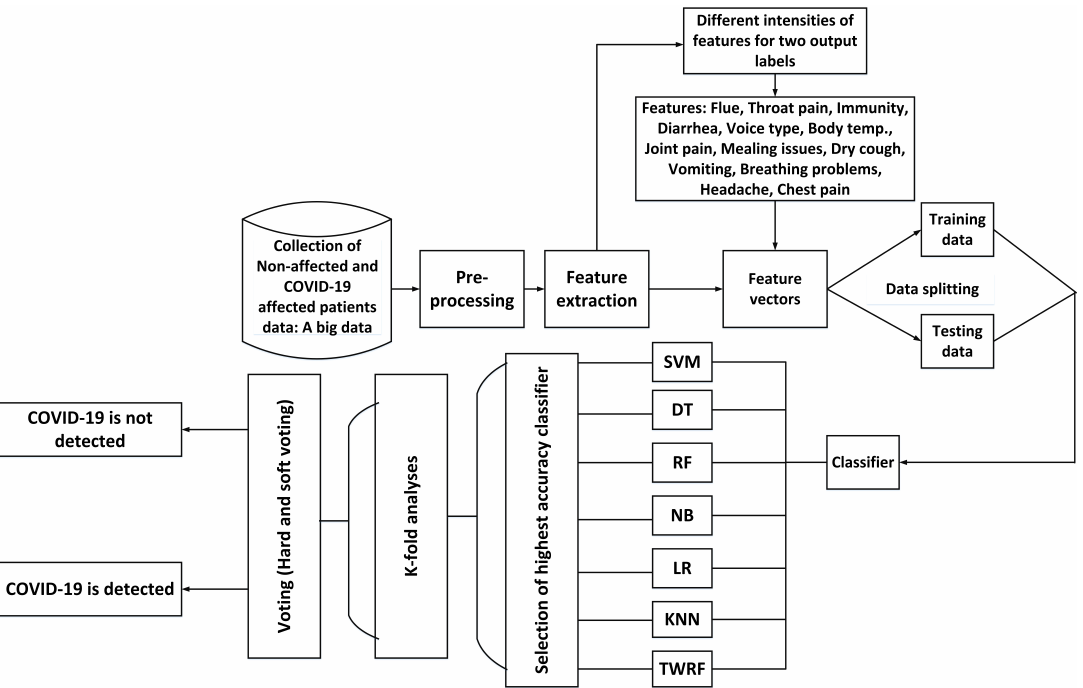
Figure 5. Flow diagram of the proposed